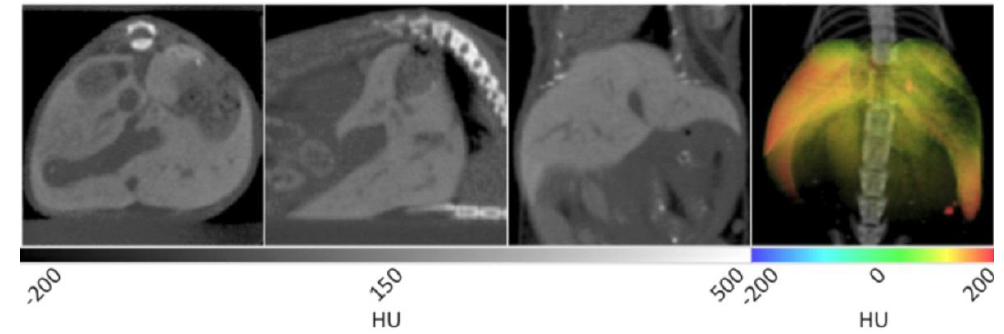
Figure 5. X-ray CT data of a murine liver with ExiTron™ nano 12000 contrast enhancement. In the first three panels, the liver tissue is distinguished from the surrounding tissues due to the uptake of contrast agent by Kupffer cells in the liver. A small amount of liver vasculature can be seen as negative contrast, especially in the coronal view in frame 3. The 3D rendering in the fourth panel shows the gross anatomical structure of the liver and spleen using a rainbow intensity